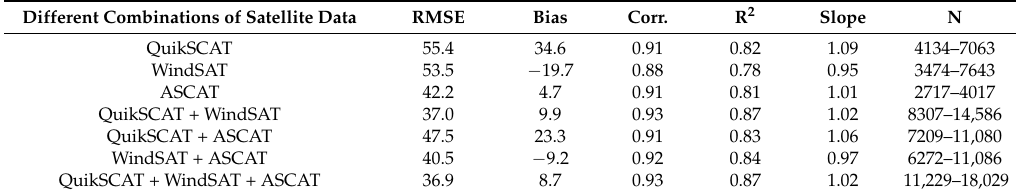
Table 3. Statistics of the comparison between buoy-derived wind power densities (WPD) and satellite-derived WPD (W/m 2 ) at a height of 10 m above sea level. Different Combinations of Satellite Data RMSE Bias Corr.